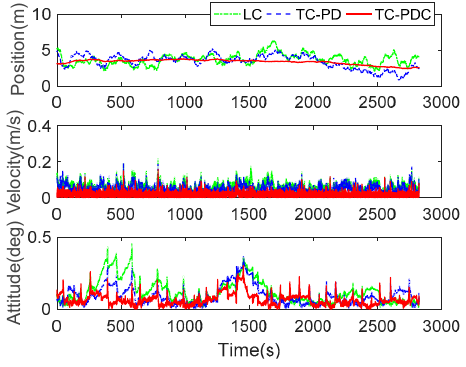
Figure 7. Navigation errors of LC, TC-PD, and TC-PDC with robust KF.